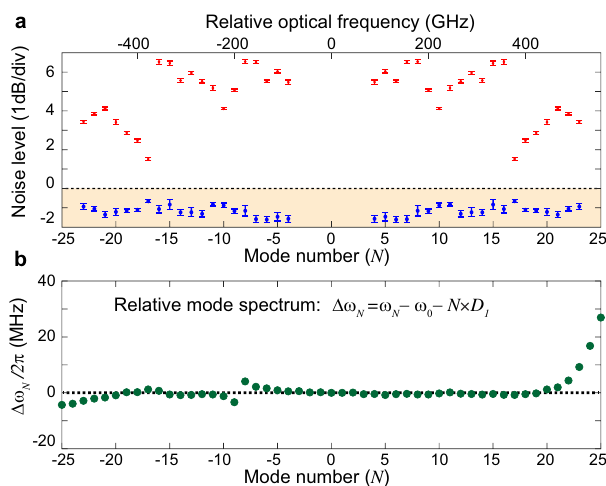
Fig. 3 Summary of squeezing and anti-squeezing levels and resonator mode spectrum. a Squeezing (blue) and anti-squeezing (red) levels versus mode number. The regime below the shot noise level is colored in orange. It should be noted that the noise level at qumode N or − N represents the two-mode noise level of comb pair ( − N , N ). The error bars are concluded with a 95% con fi dence interval under t-distribution. b The cold resonator mode spectrum ( Δ ω N , relative mode frequency). The degradation of squeezing/anti-squeezing level of certain qumodes is likely caused by the avoided mode crossing induced by spatial-mode-interaction in the